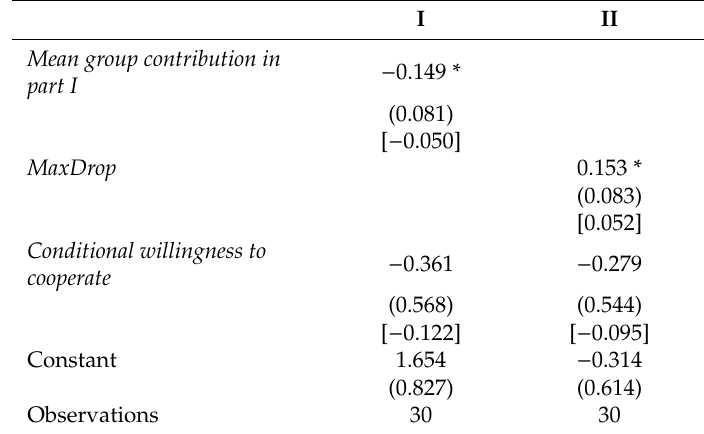
Table 6. Binary probit estimations on replacement decisions (1 = yes) in Endo by the decision-maker.